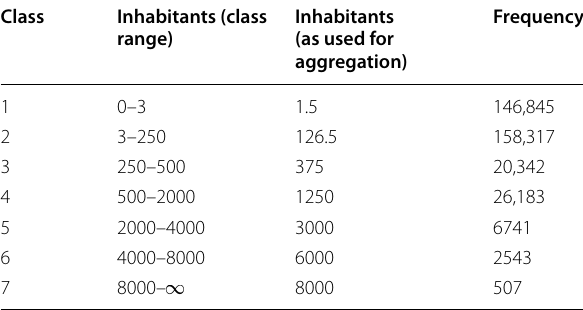
Inhabitants classes and class ranges as used in the German census Zensus 2011, the corresponding inhabitant numbers used for spatial aggregation in this study, and the number of grid points of a specific